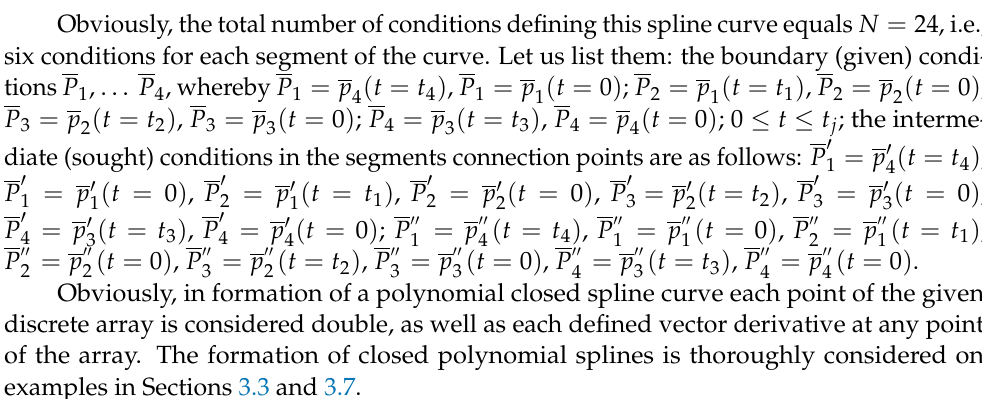
Figure 5. Closed spline curve based on a fifth-degree polynomial.